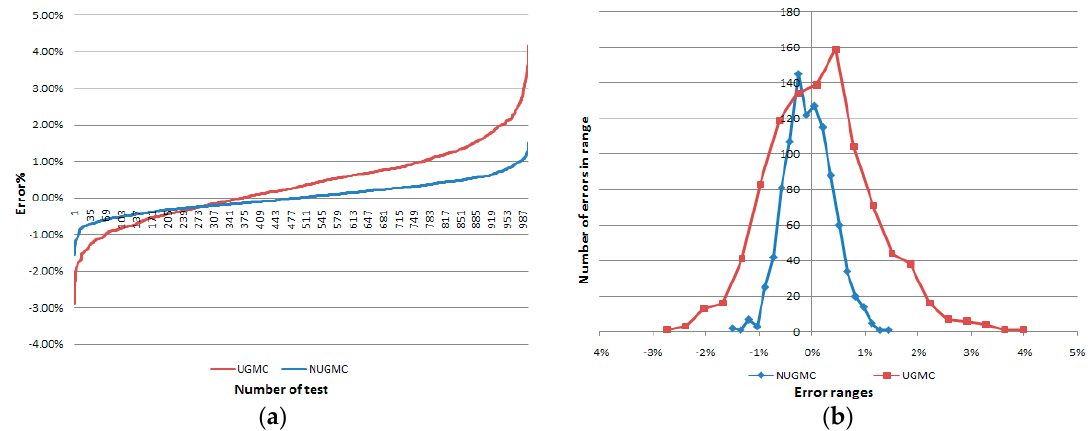
Figure 9. Comparison of the errors with UGMC and NUGMC for the case in Figure 4c after 1000 tests with the same number of computations (7 × 10 5 ): ( a ) calculated and sorted errors and ( b ) histogram of those errors.